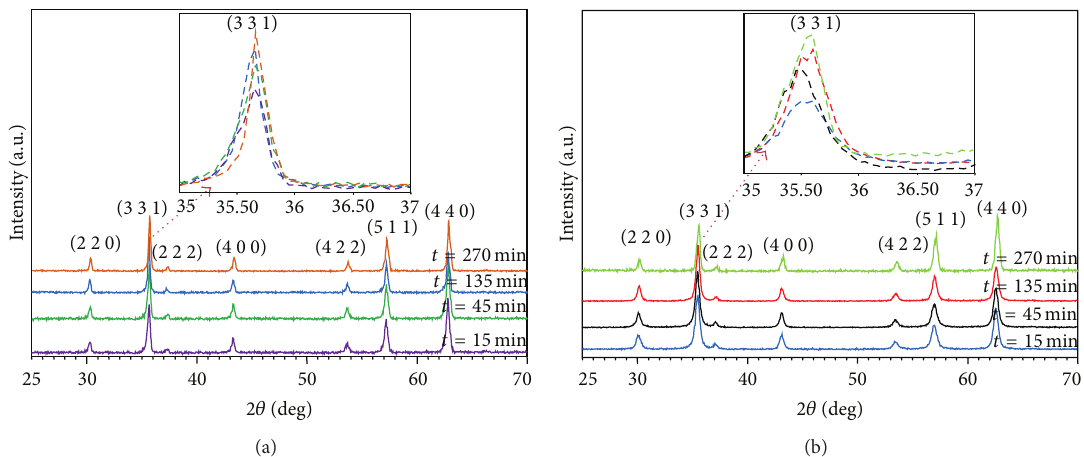
Figure 1: X-ray diffraction patterns for (a) Ni 0.36 Zn 0.64 Fe 2 O 4 ferrite without additive and (b) with 0.12 (0.4CaO + 0.8SiO 2 ) additive at different sintering